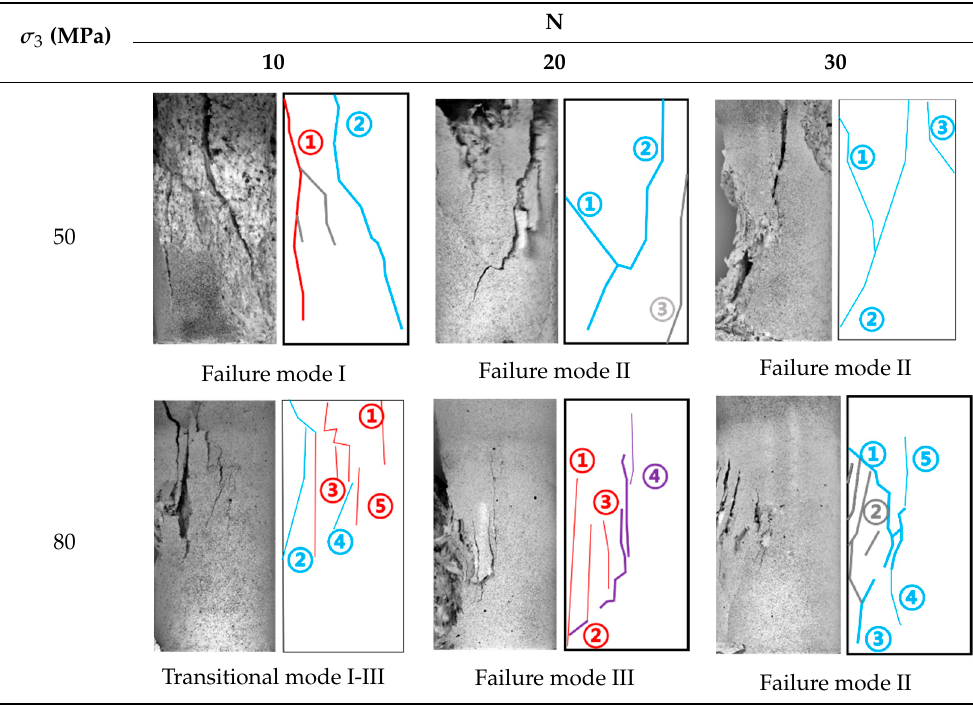
Table 4. Failure mode of pre-damaged specimens under uniaxial compression.